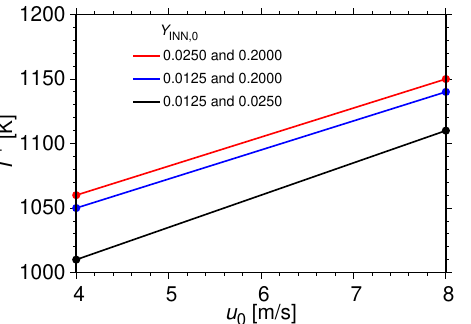
Figure 7. T + versus relative velocity for different initial INN mass fractions. Initial conditions: T l,0 = 293.15 K, p = 1